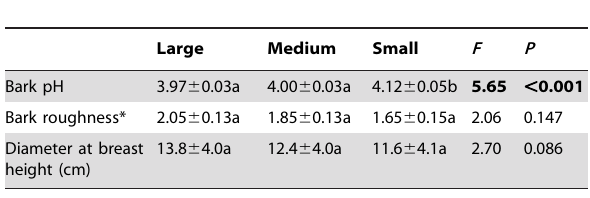
Bark roughness* Diameter at breast height (cm) Values given are Mean 6 SE. DF=2, 27. *Three level scale from smooth to very rough. Letters distinguish significant differences ( P , 0.05, Tukey’s post hoc test). doi:10.1371/journal.pone.0049081.t003 PLOS ONE |